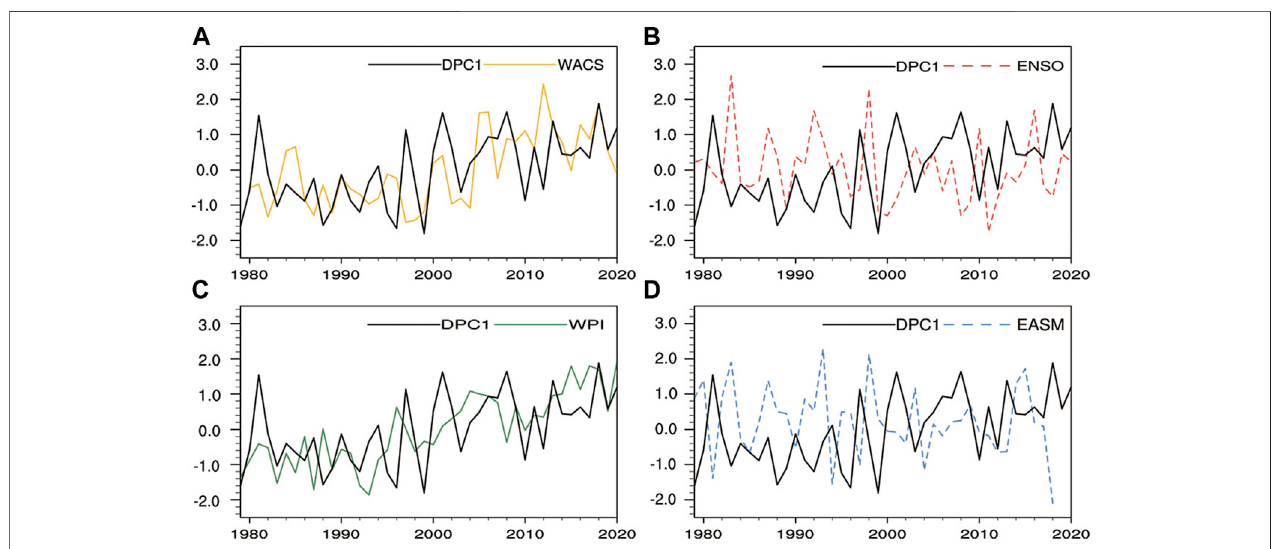
FIGURE6| DPC1seriesandthepreviouswinter (A) WACSindex, (B) ElNiño – SouthernOscillation(ENSO)index,thesummer (C) westernPaci fi cwarmpoolindex and (D) EASM index series.